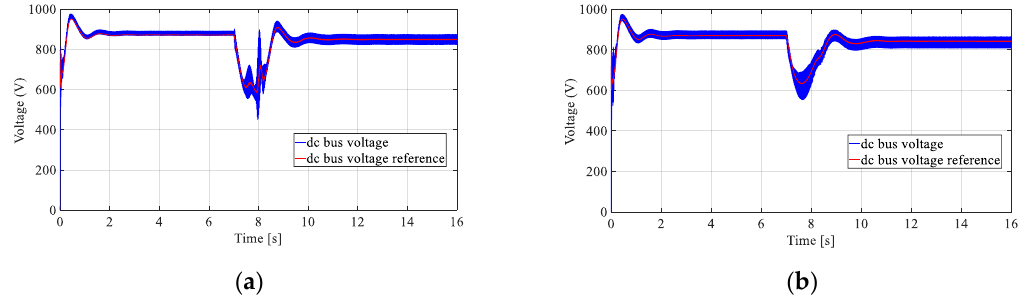
Figure 6. dc bus voltage: ( a ) CMPPT control; ( b ) DMPPT control.